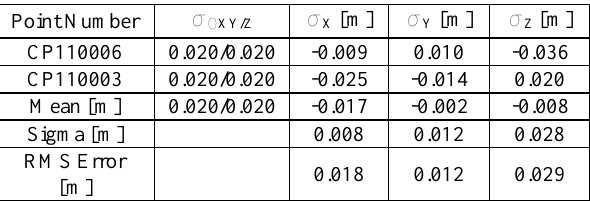
Table 5. Residuals of the check points